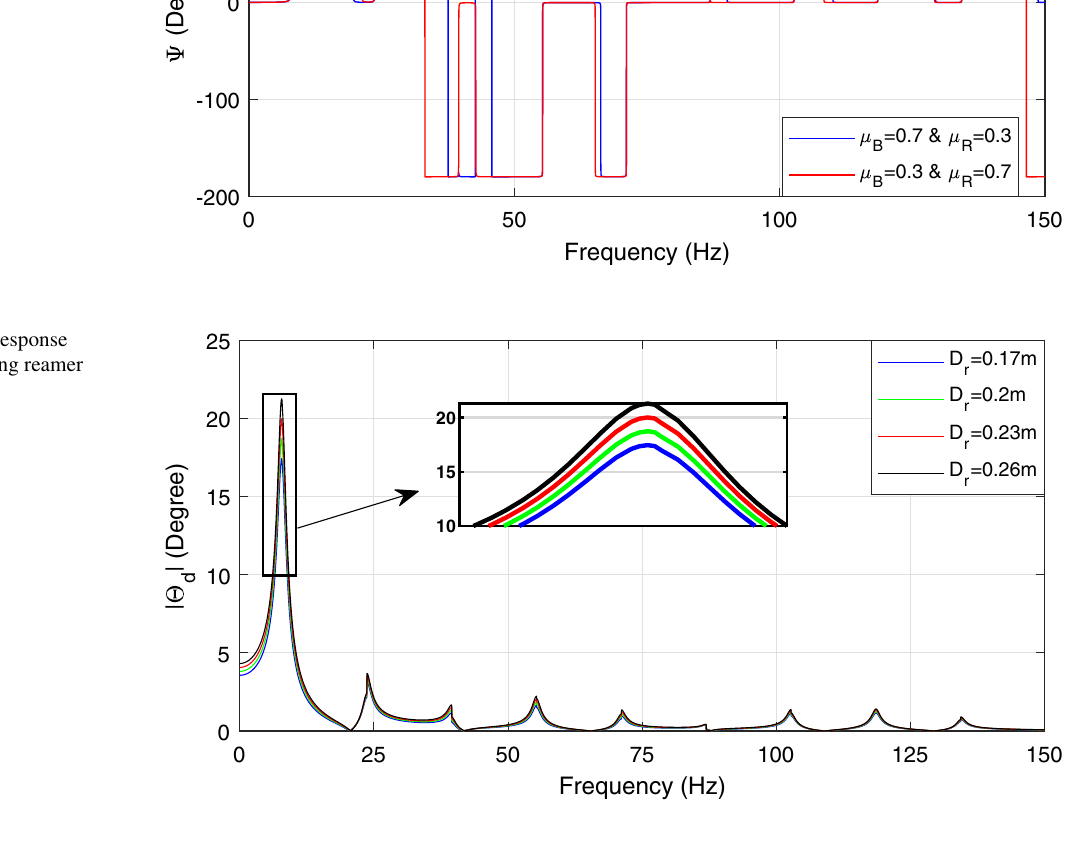
Fig. 10 Phase frequency response magnitude for different cutters aggressiveness